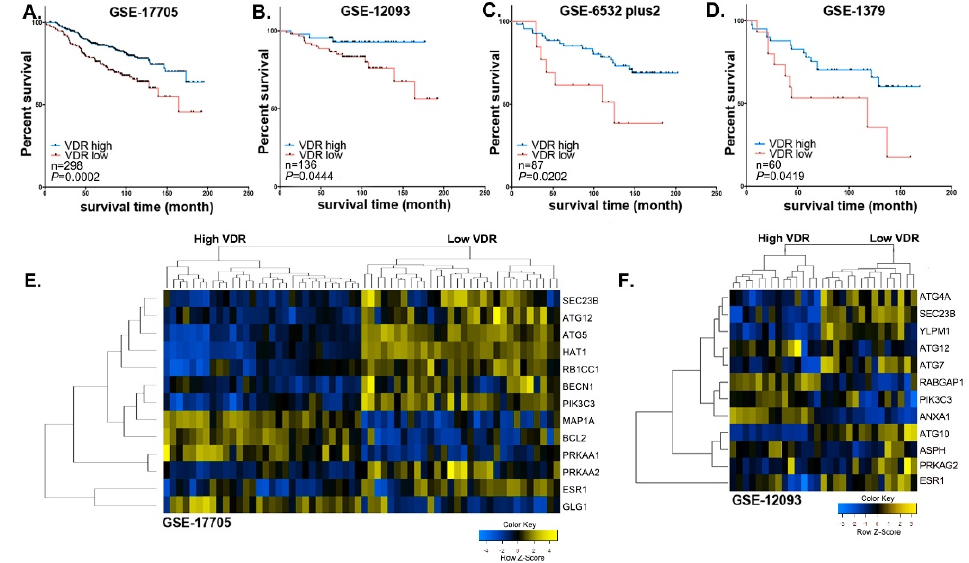
Figure 1. VDR expression and breast cancer survival and autophagy-related gene expression in tamoxifen-treated patients. Recurrence-free survival of ER+ breast cancer patients with above versus below median VDR expression in the following GEO datasets: ( A ) GSE-17705 [31], ( B ) GSE-12093 [32], ( C) GSE-6532 [33], and ( D ) GSE-1379 [34]. Cutoff optimization was done using R environment for each dataset. Cluster analyses of autophagy-related genes are shown in the heat maps for ( E ) the dataset of GSE-17705; and ( F ) the dataset of GSE-12093.